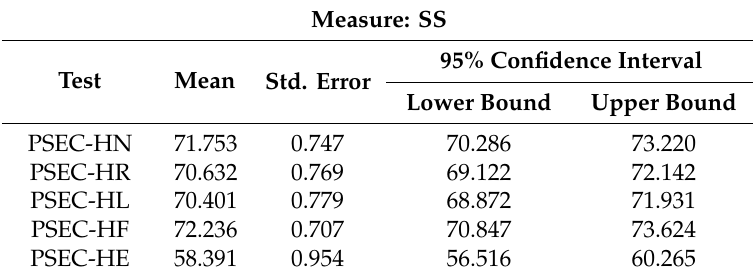
Table 10. Concussion patients’ postural stability scores with head rotation.